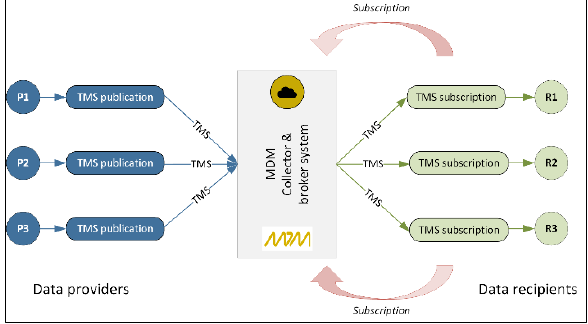
Figure 4. MDM as data